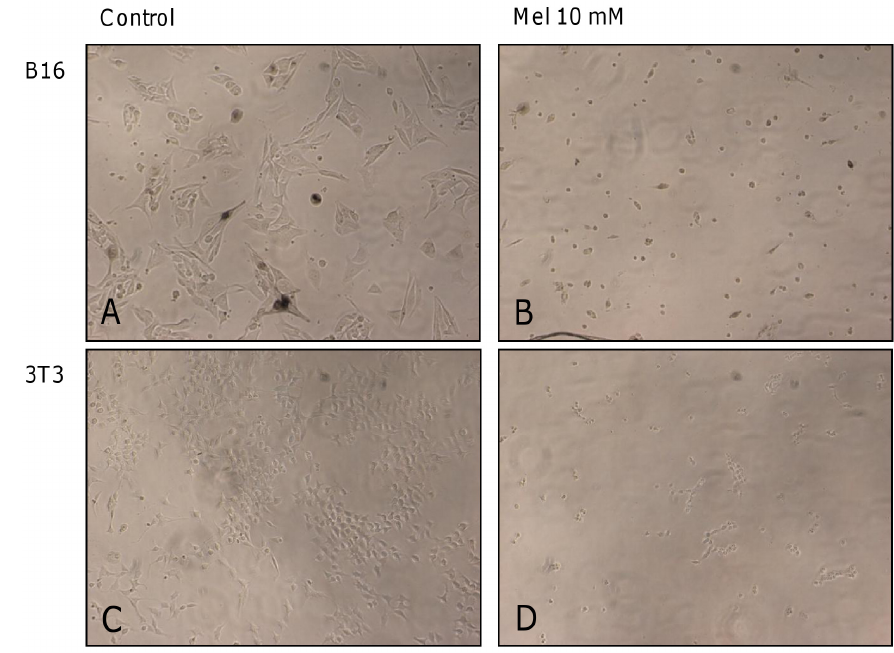
Figure 5. Lethal effect on melanoma (B16) ( A and B ) and fibroblast cell lines (3T3) ( C and D ) in the presence of FBS. Microphotographs in A and C represent untreated control cells. Microphotographs B and D are taken from cell cultures treated with 10 mM melatonin after 48 h. A loss of cell structure can be clearly observed. The images were obtained using a 20× objective.